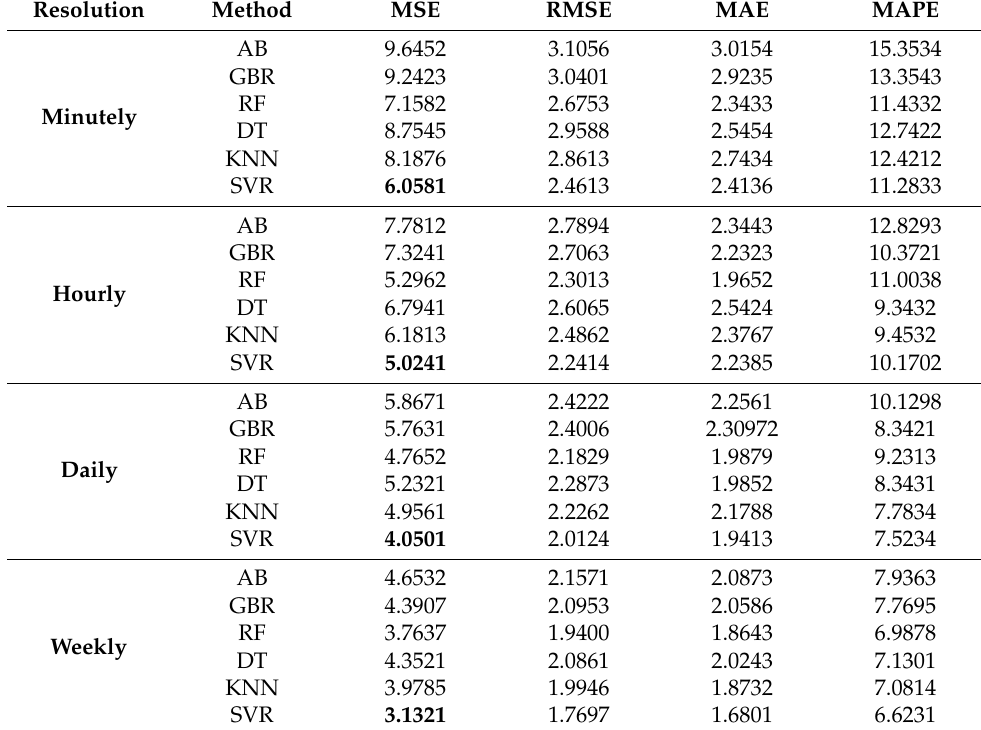
Table 7. Results obtained using ELA on different horizons using 10-fold